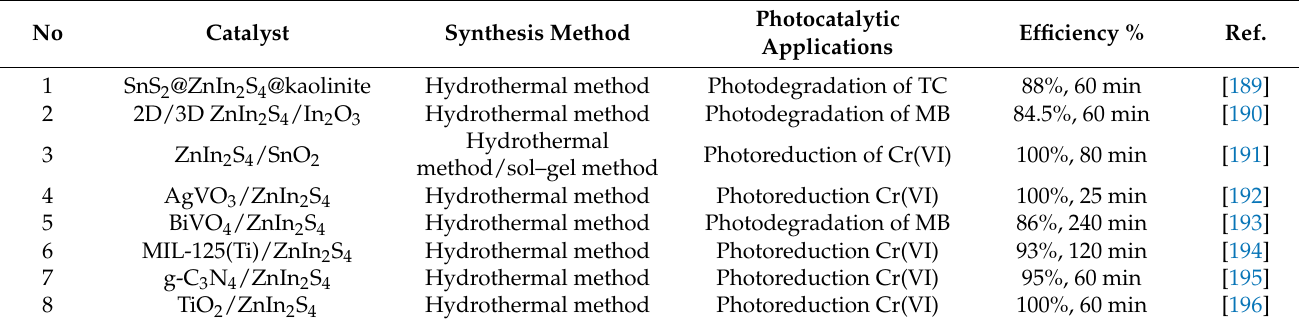
Table 3. A list of ZnIn 2 S 4 -based semiconductor heterojunction